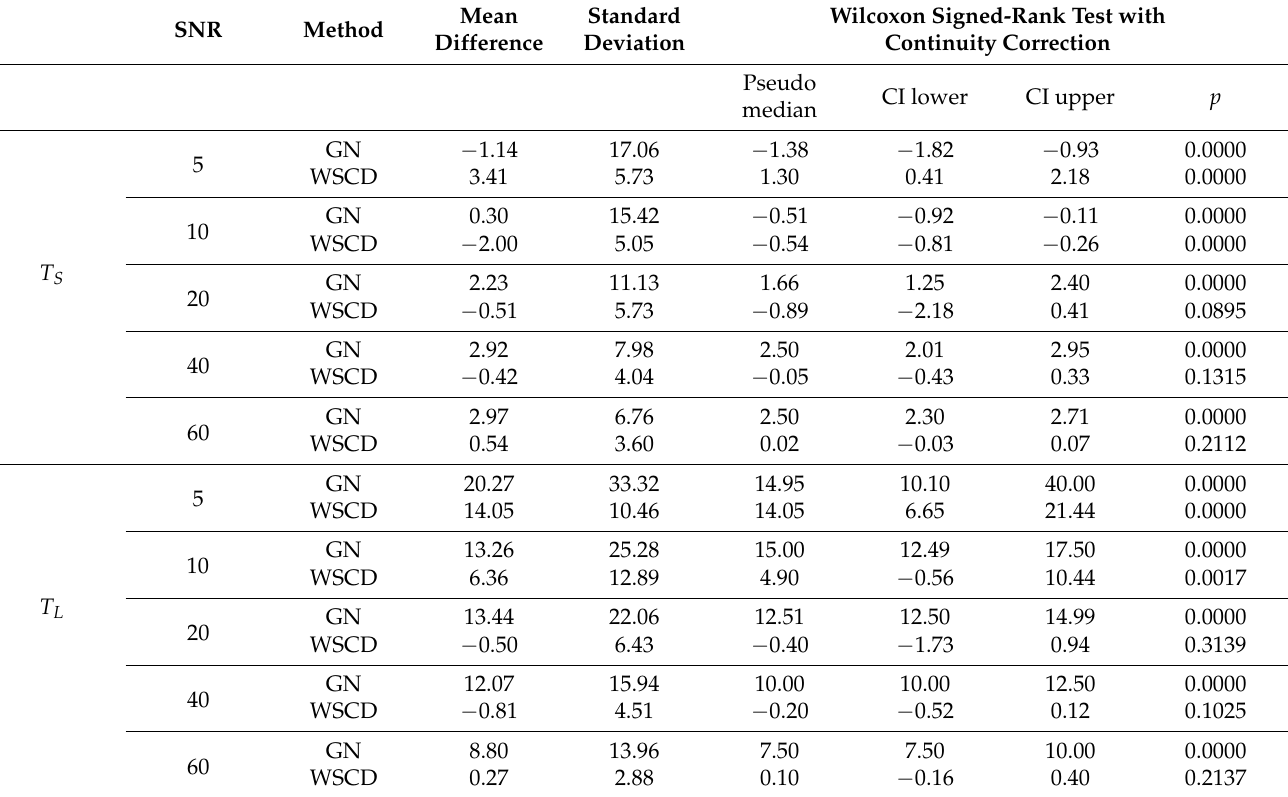
Table 1. Detailed results of the accuracy of the GN and WSCD reconstruction methods. Significant deviations from true T 2 time values for short ( T S ) and long ( T L ) components were obtained for all SNRs based on the GN method and for SNRs < 20 based on the WSCD method. The WSCD method with an SNR ≥ 20 did not show a significant deviation from the true T2 values. The statistical analysis was performed with the Wilcoxon signed-rank test with continuity correction. The numerical values of the mean difference from true T2 values, standard deviation from the pseudomedian, and confidence intervals (CI) of T S and T L are given in